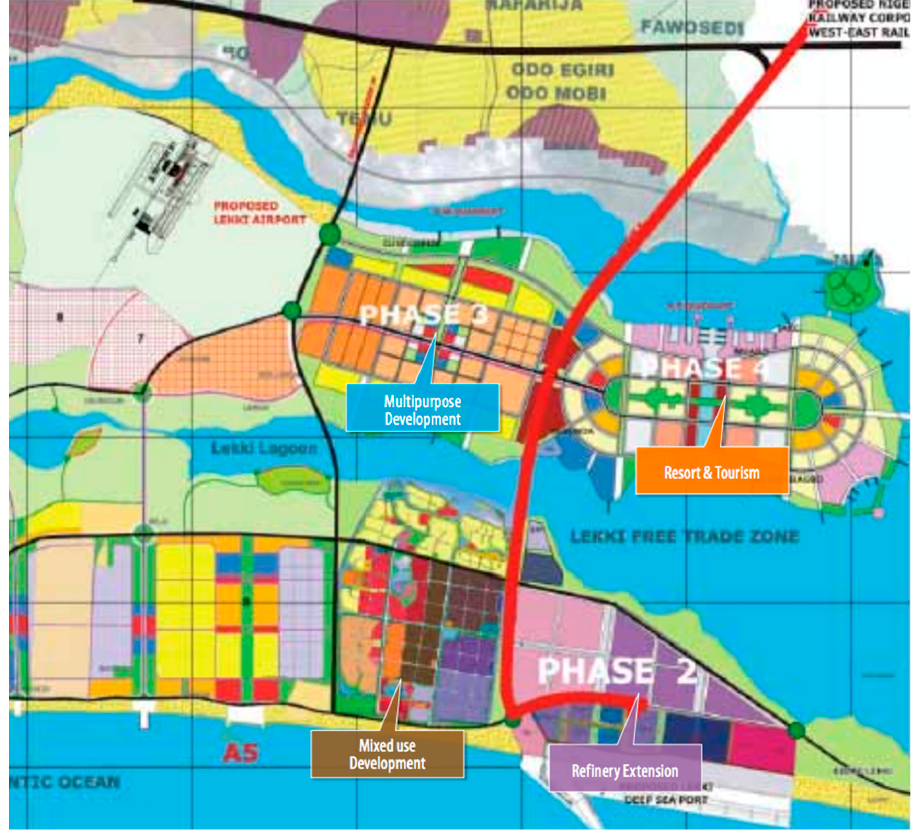
Figure 1. Lekki Free Trade Zone Master Plan.